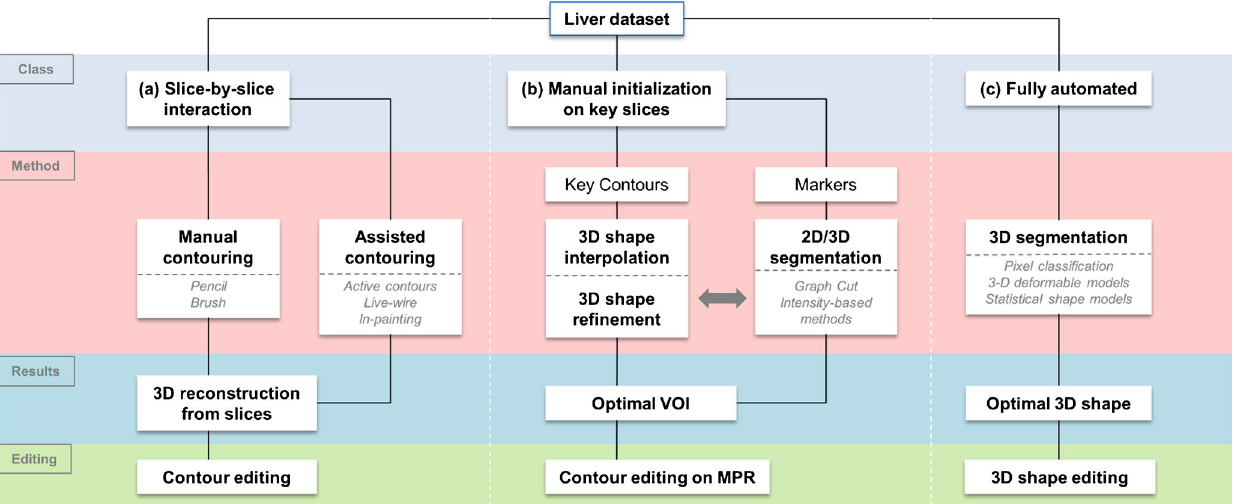
Fig. 7 Workflows of various segmentation strategies. The schematic breaks down liver segmentation methods into truly manual, contour optimisation, semi-automated, and fully automated workflows.